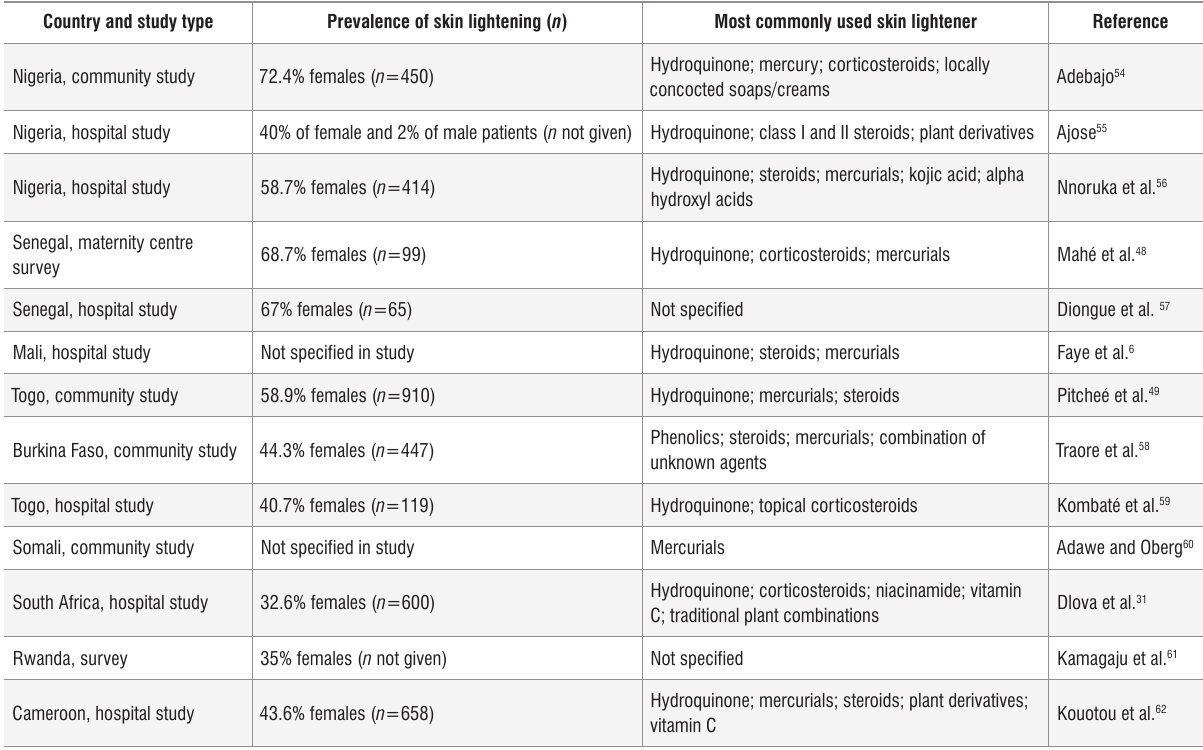
Table 1: Summary of the global prevalence of skin lightening practices in Africa and the most commonly used skin formulations Country and study type